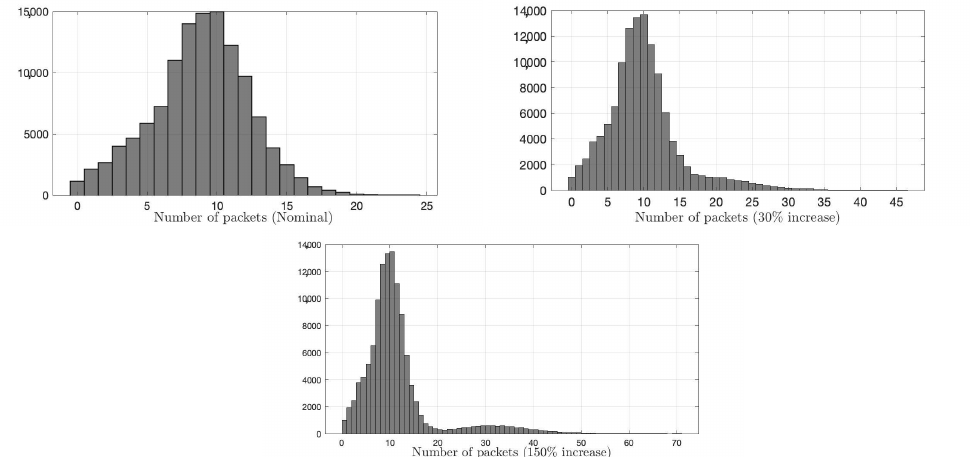
Figure 10. Histogram of number of packets for a road segment. The first histogram represents the distribution of nominal data, whereas the second and third represent attack cases an average increase that is 0.3 and 1.5 times the baseline, respectively. Nominal and attack distributions are close to a normal distribution with extended tails under